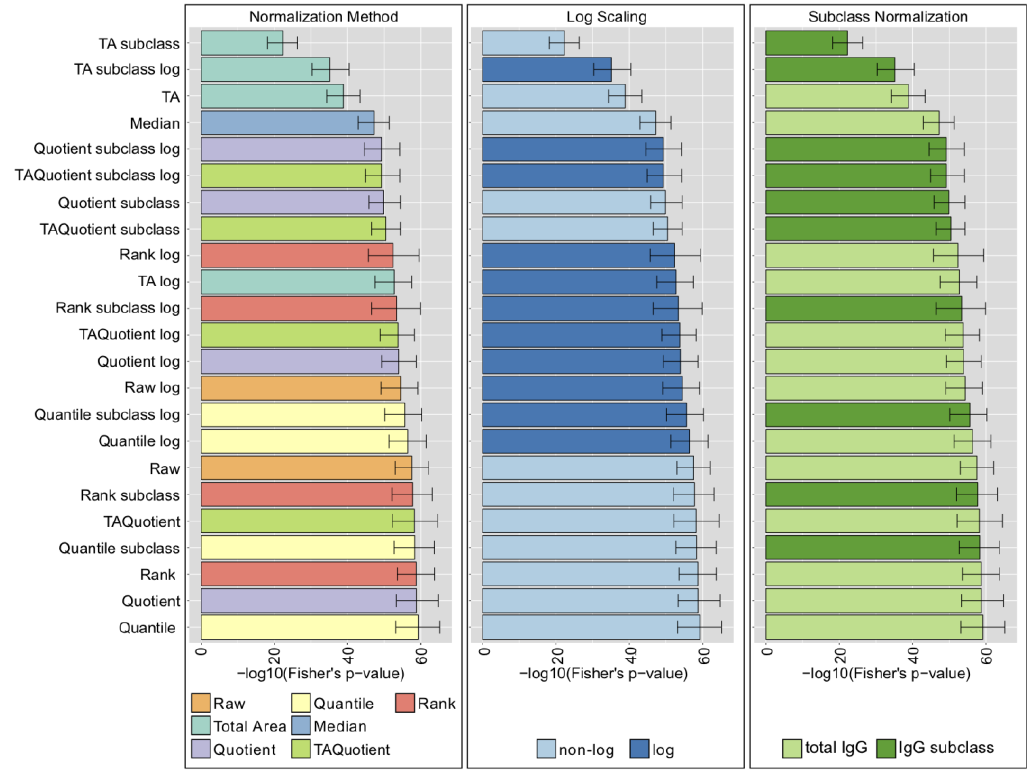
Figure 3. LC-ESI-MS normalization analysis results (Korčula 2013 cohort). Results in the panels are colored according to type of normalization (left), log-transformation (center), or normalization per IgG subclass or total IgG (right). Bars represent the median of the Fisher’s exact test p -values over 1000 bootstrap samples, and error bars indicate the corresponding 95% confidence intervals.